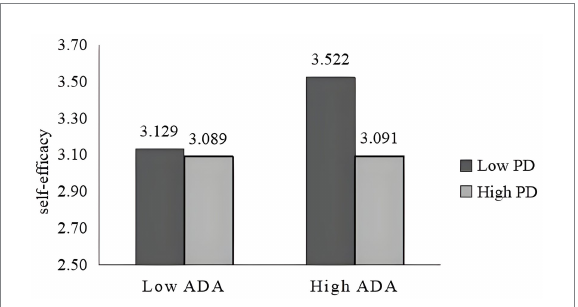
FIGURE 5 The moderating effect of power distance on self-efficacy.